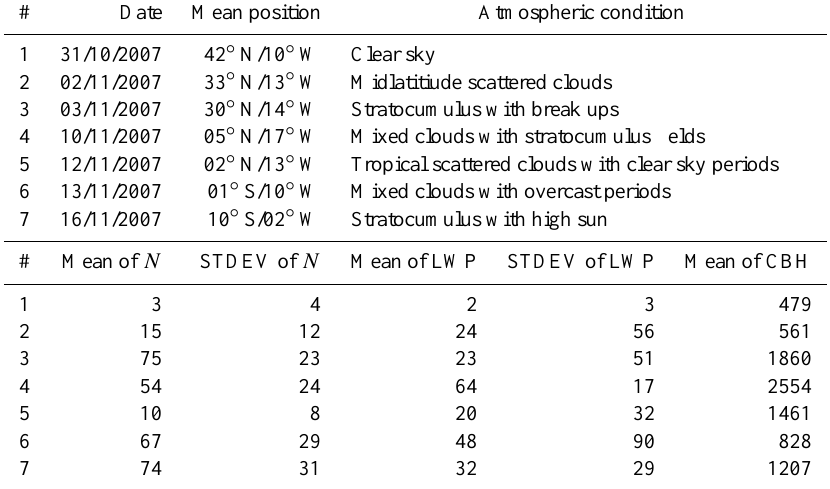
Table 2. Top table: overview of the days used within this study with their mean location and atmospheric condition. Bottom table: daily